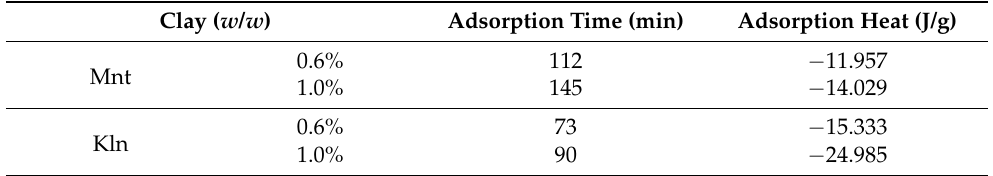
Table 2. Heats of adsorption with different equilibration times for the different concentrations of clays with saturates at 298